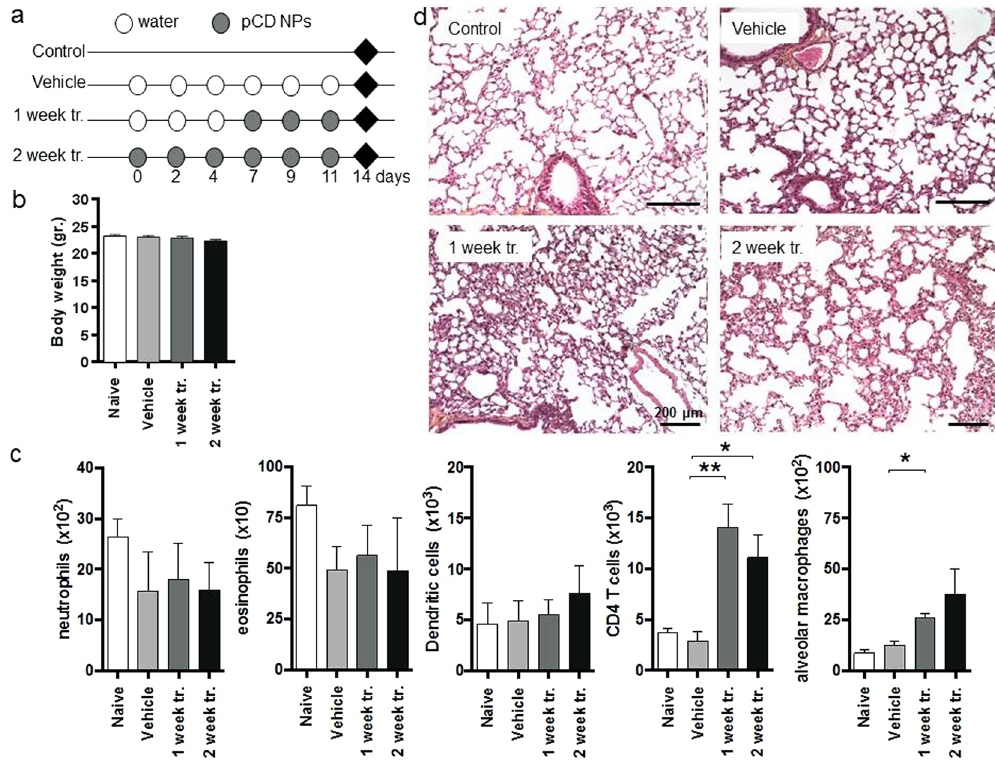
Figure 5. Impact of pCDs NPs administration on pulmonary homeostasis in mouse. ( a ) Protocol. Water (Vehicle) or nanoparticles were administered to mice via the endotracheal route during one (1 week tr.) or two weeks (2 week tr.); ♦ = mice euthanasia. ( b ) Body weight of mice after each treatment. ( c ) Analysis of the recruitment of immune cells in the lungs parenchyma by flow cytometry. The data represent the number of selected cells on 500,000 events; To define the different cells populations we used the following phenotypes: neutrophils (CD11b + GR1 + ), eosinophils (F4/80 + SiglecF + ), CD4 T cells (CD3 + CD4 + ), alveolar macrophages (CD11c + F4/80 + ) and dendritic cells (CD11b + CD11c + ); the Data are mean values ± standard deviation of one representative experiment of two independent experiments; * p < 0.1, ** p < 0.01. ( d ) After treatment, lungs were analysed by histology (H-E staining, scale bar: 200 μ